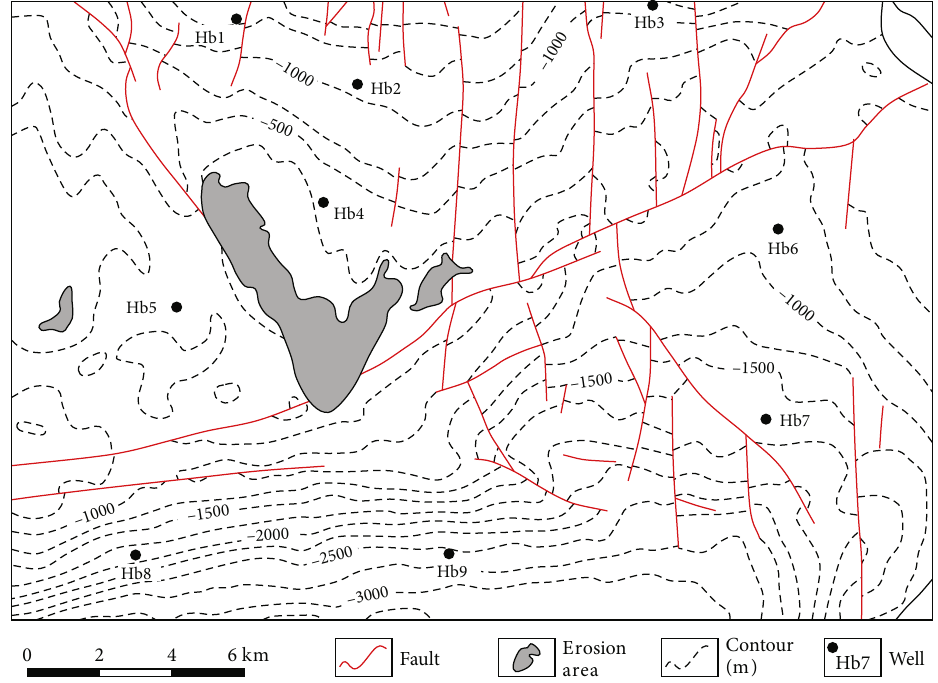
Figure 2: Structural framework of Haiba Block in the southern Sichuan Basin, China (The contours indicate the burial depth of bottom Wufeng Formation — Lower Silurian Longmaxi